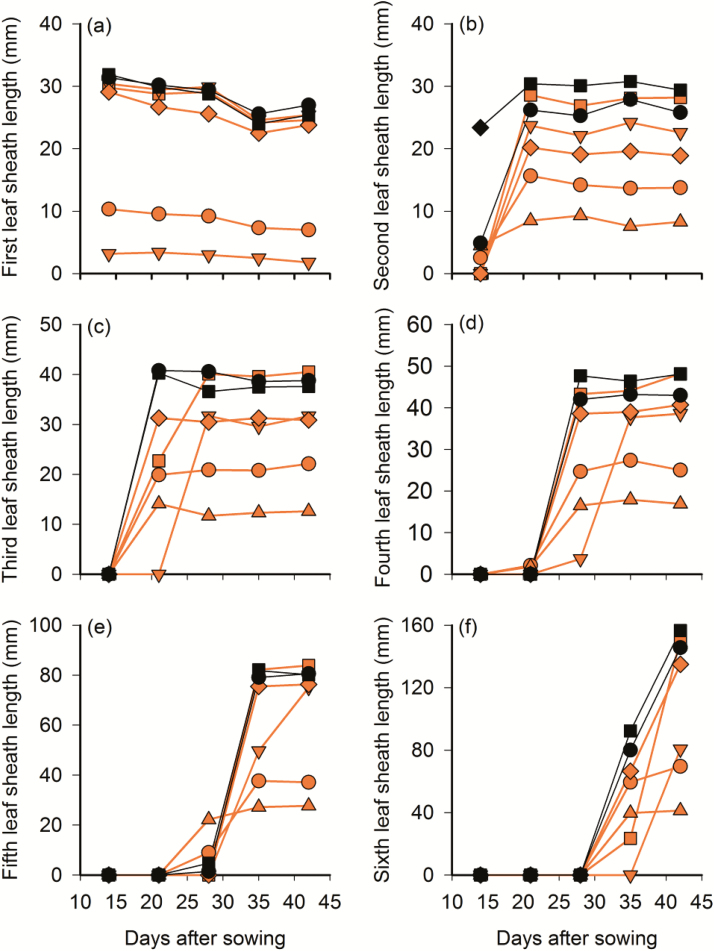
Leaf sheath growth patterns of five spring wheat mutant lines and their non-mutated parent cultivars in added FR light (R:FR 0.4). Mutants depicted in orange and non-mutated cultivars in black lines and symbols. Red circles: A9, red squares: A20, inverted triangles: A48, triangles: T104, diamonds: A151, black circles: Amaretto, black squares: Triso.